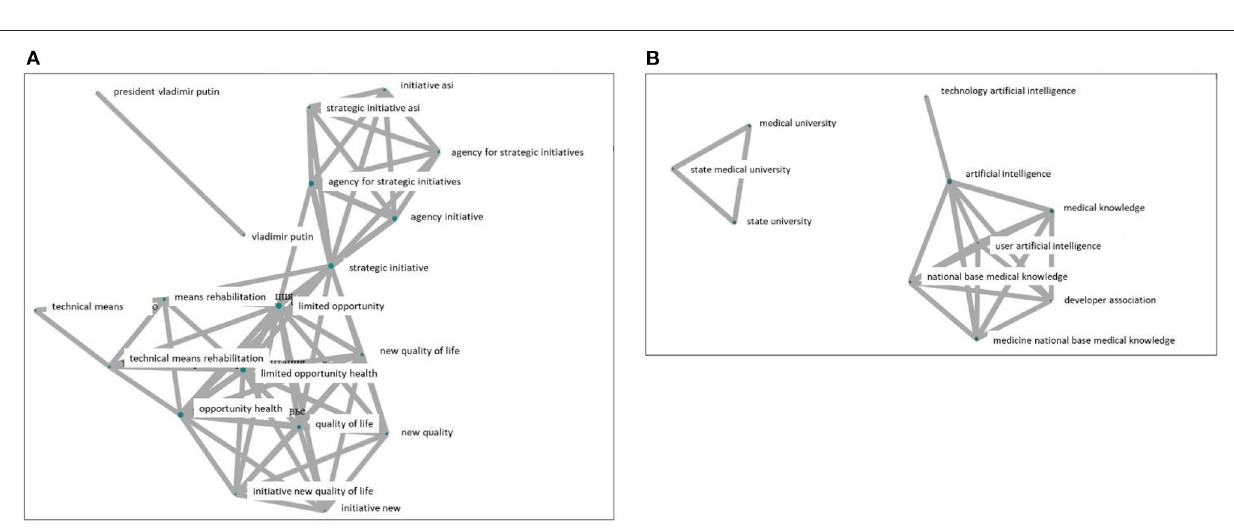
FIGURE 2 | Visualization of keyphrases from ASI’s site, link frequency p > 10 (2014–2017) (A) , and from NTI’s Facebook page, link frequency p > 4 (2015–2019) (B)